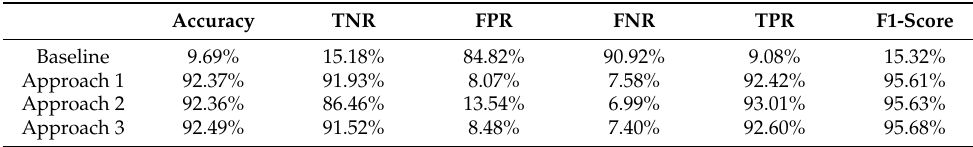
Figure 6. ROC curves for the baseline and the three approaches in the second test case. Table 8. Results of the second test